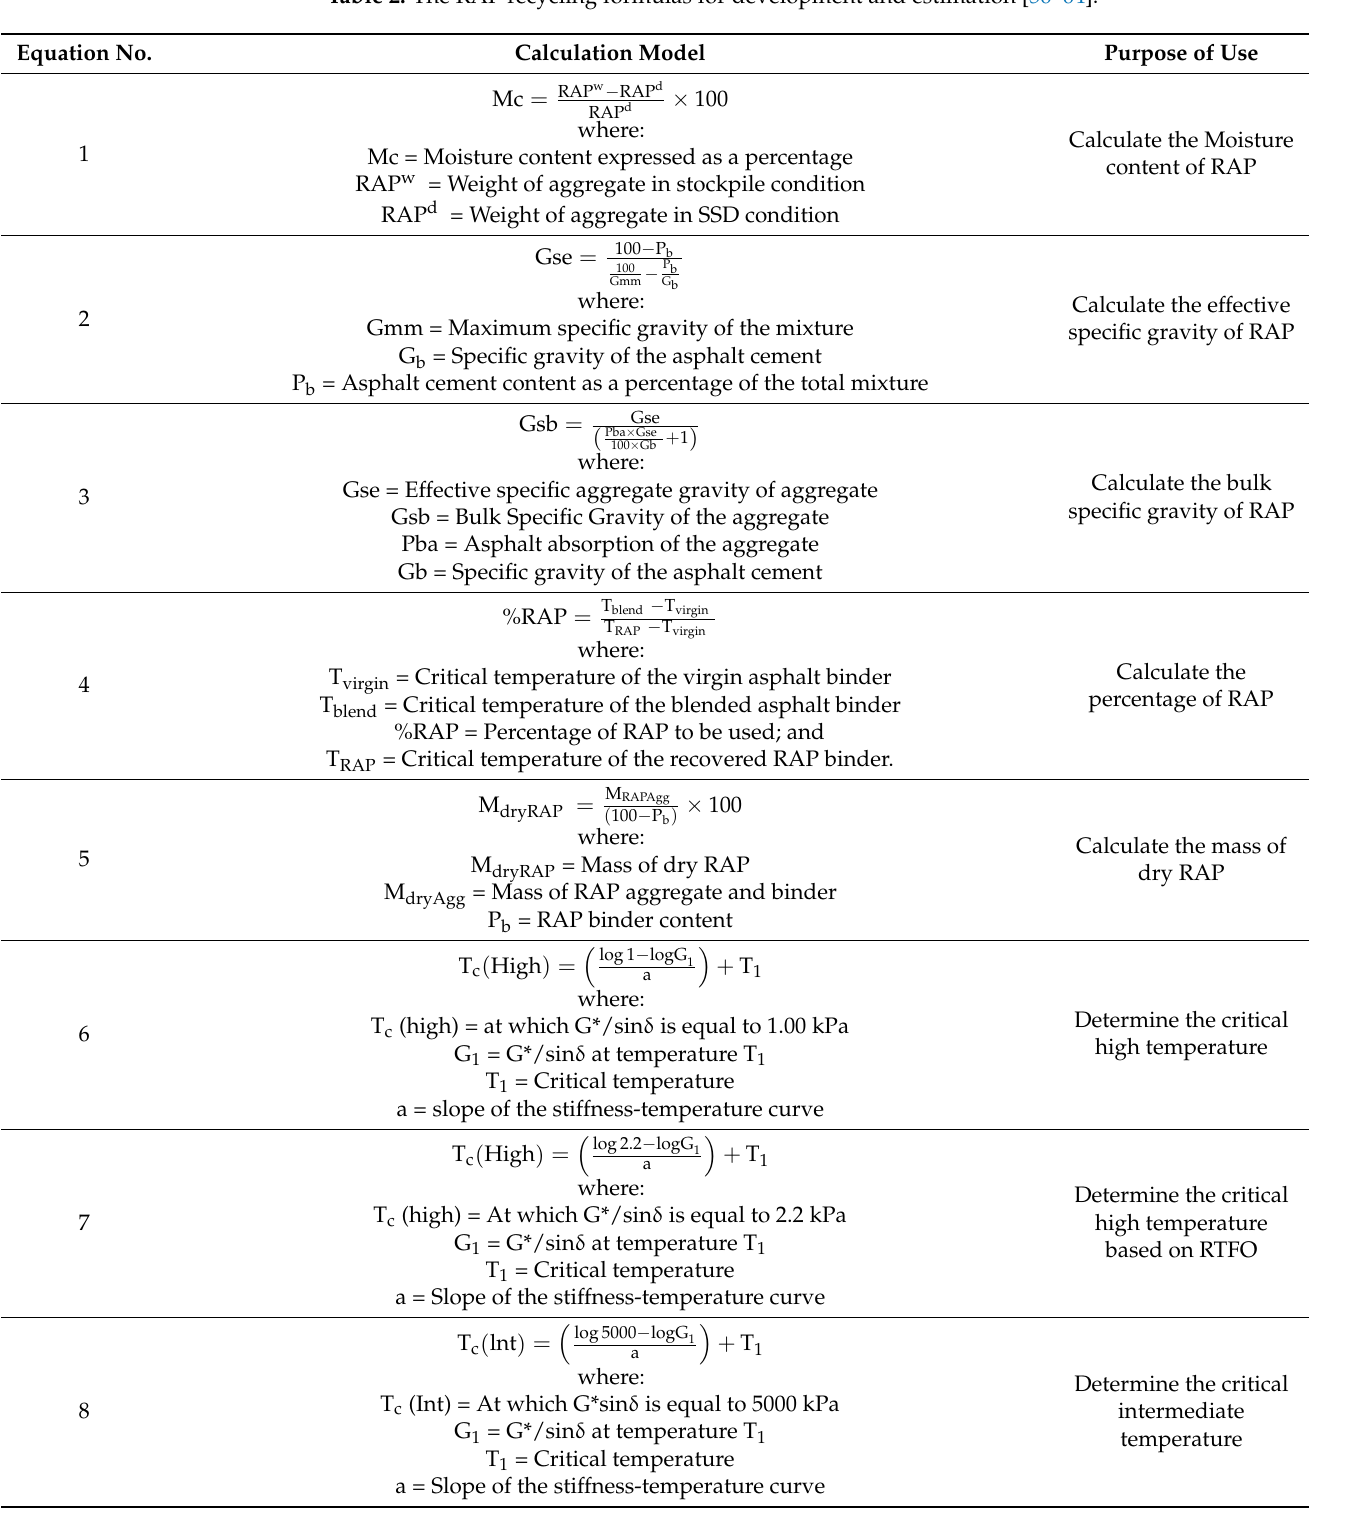
Table 2. The RAP recycling formulas for development and estimation